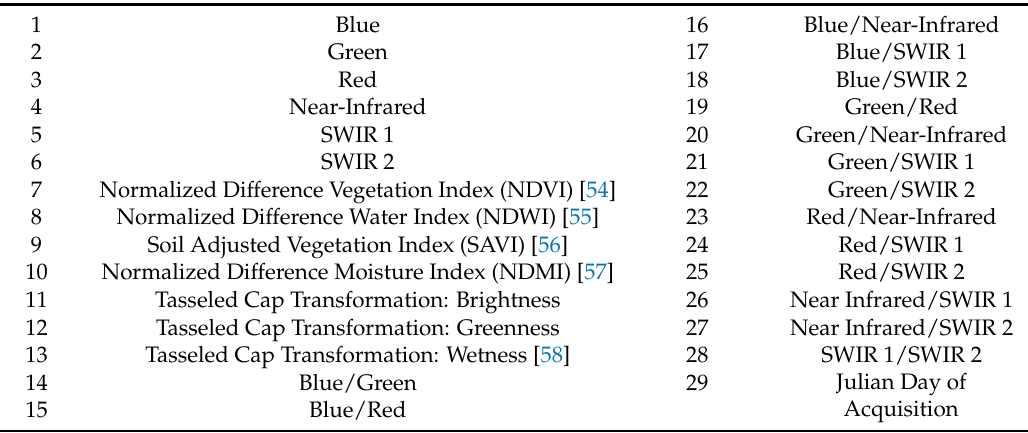
Table 9. List of predictor variables generated from Landsat 5